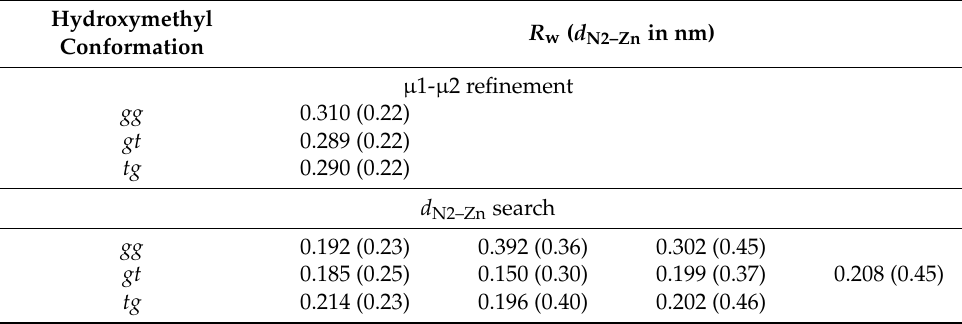
Table 2. Summary of ab projection structure analysis.